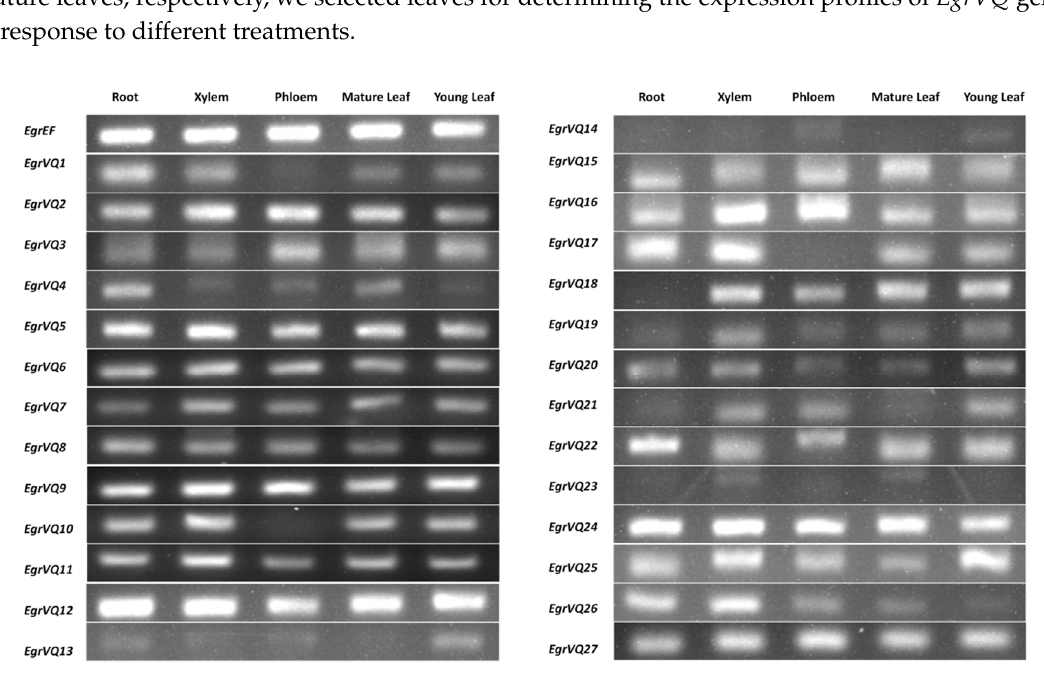
Figure 6. Semi-quantitative Real-Time PCR (RT-PCR) of the expression of EgrVQ genes in different tissues. From left to right: root, xylem, phloem, mature leaves, and young leaves. All of these tissues were collected from 6-week-old GL1 plants.